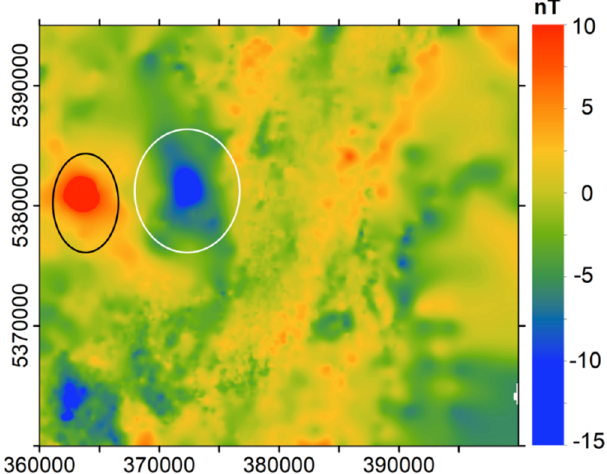
Figure 9. The gravity residual misfit of the Rosebery Region reference model. The rms misfit was 2.29 mGal. Note the longer-wavelength negative residual (shown by the white ellipse) and positive residual (shown by the black ellipse) associated with the Huskisson Syncline. These residuals indicate inadequate model geometry.